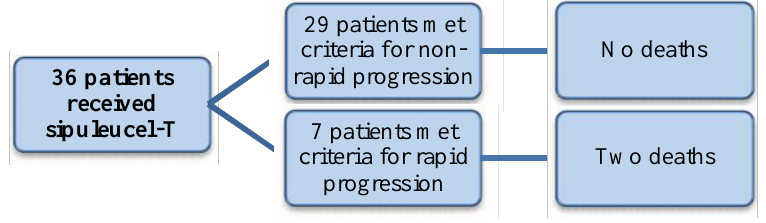
Figure 1. Delineation of rapid progression group and non-rapid progression groups.